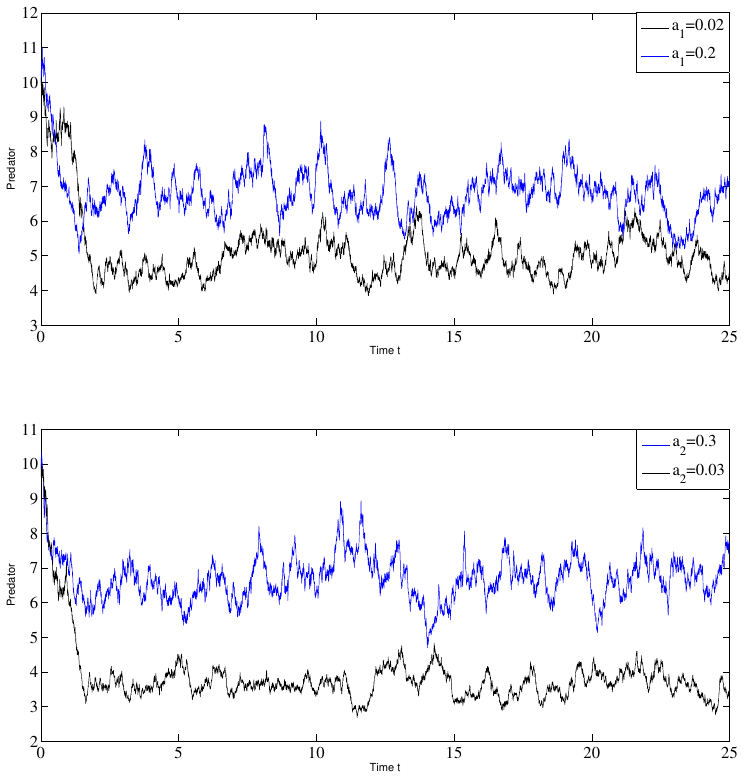
Figure 4. The behavior of the predator population for different values of a 1 and a 2 .